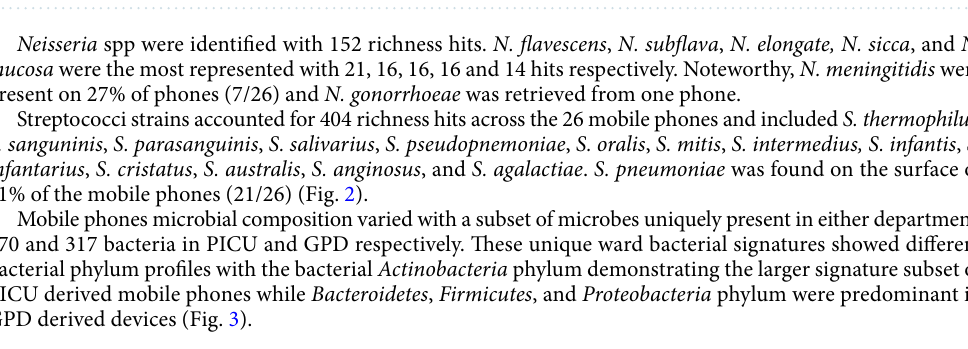
Figure 2. Clinically relevant pathogenic bacteria identified across all 26 mobile